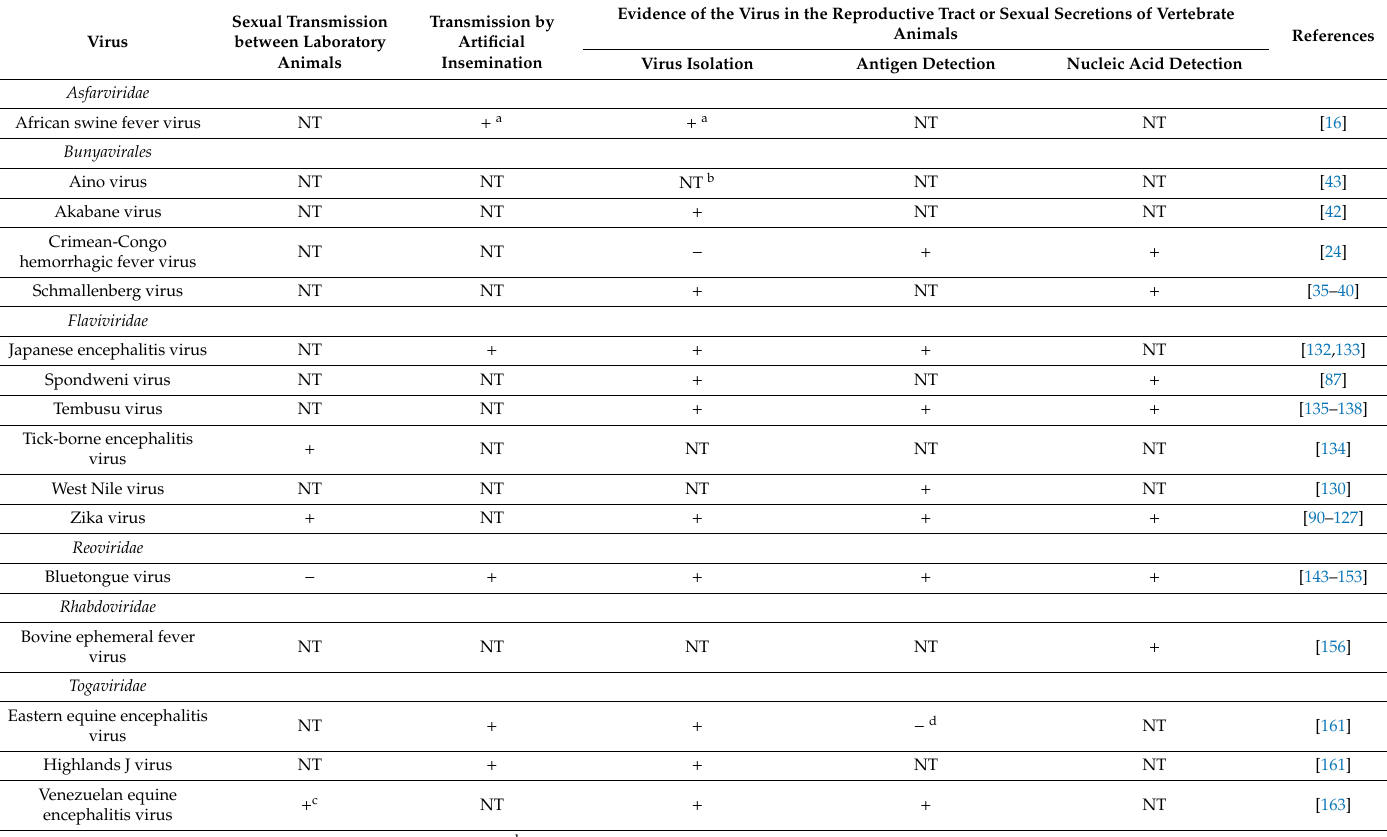
Table 2. Arboviruses with the potential to be sexually transmitted between vertebrate animals as determined by laboratory mating experiments, artificial insemination or the presence of the virus in the reproductive tract or sexual